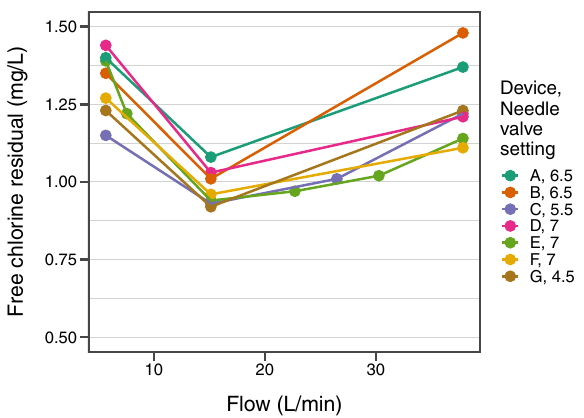
Fig. 2 Free chlorine residual (mg/L) in water collected from the Venturis in the lab by fl ow rate (L/min). The needle valve determines a precise amount of chlorine fl owing toward the Venturi and may be adjusted. Needle valve settings correspond to the rotation of the needle valve from closed to open. The settings range from 0 to 10, with 0 representing fully closed and 10 representing fully open. The settings are marked on the needle valve. The needle valve settings shown were selected in the lab and used at installation in the fi eld.